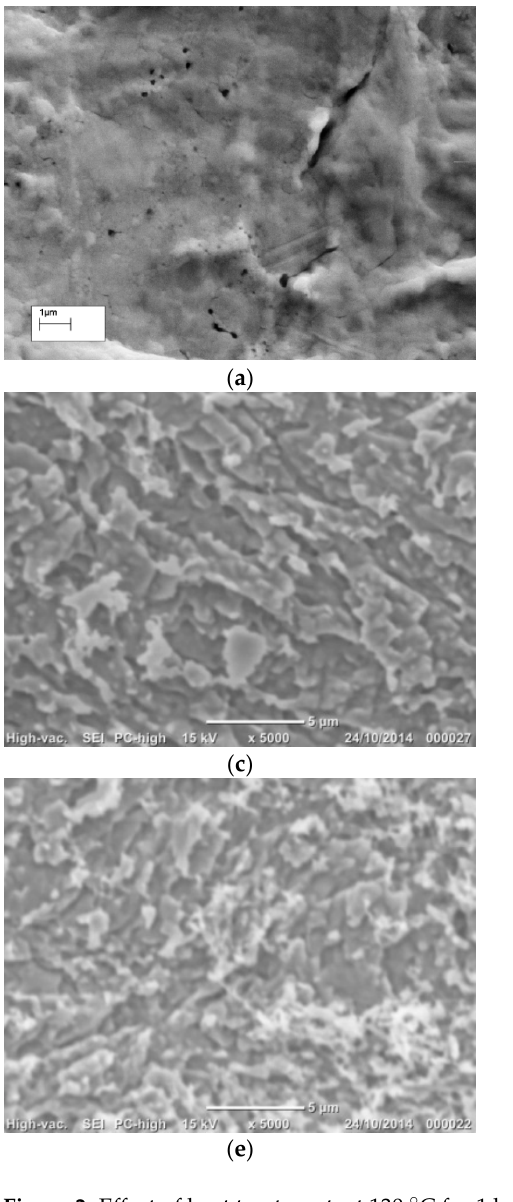
Figure 2. Effect of heat treatment, at 130 °C for 1 h, on surface morphology of the different chemical etched Ag surfaces: ( a ) native flattened Ag wire washed in DI water under sonication; ( b ) 30 s NH 4 OH; ( c ) 10 s HNO 3 ; ( d ) 2 m HNO 3 ; ( e ) 30 s NH 4 OH followed by 10 s HNO 3 ; and ( f ) 30 s NH 4 OH followed by 2 m HNO 3 .